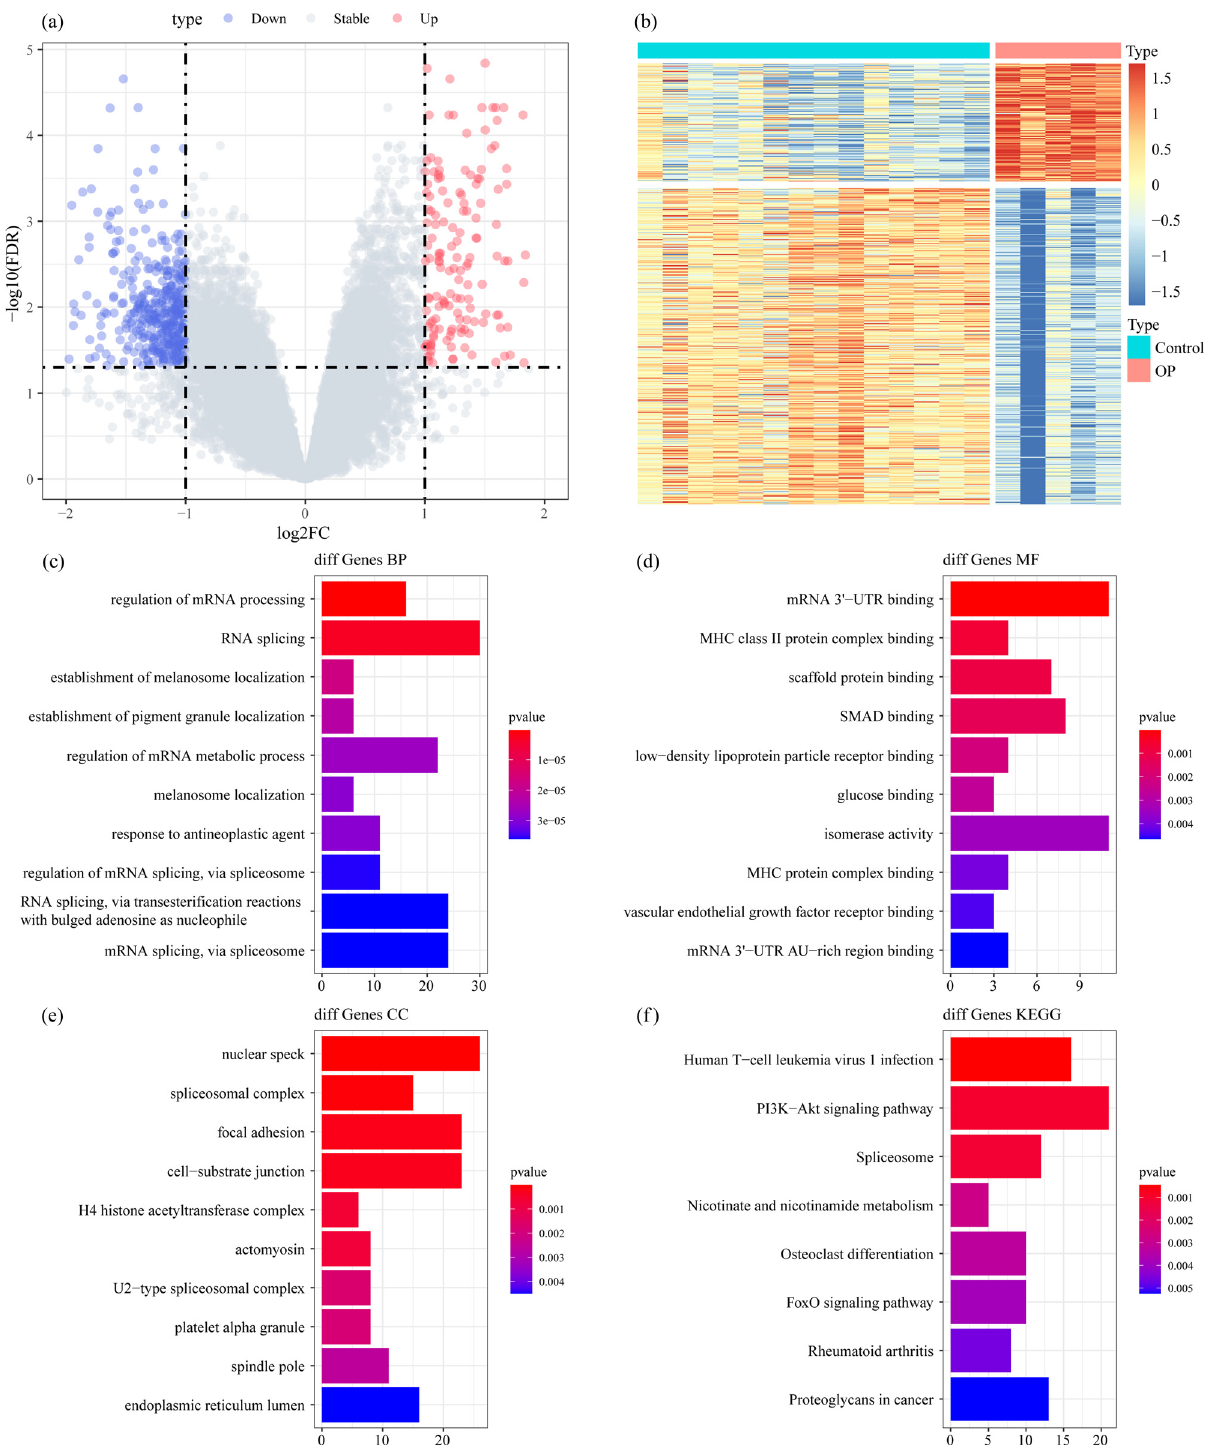
Figure 2: Identi fi cation of DEGs: ( a ) the volcano map of DEGs in GSE35959 dataset, ( b ) the heat map of DEGs in GSE35959 dataset, ( c ) the BP annotation map of DEGs, ( d ) the CC annotation map of DEGs, ( e ) the MF annotation map of DEGs, and ( f ) the KEGG annotation map of a total of 15 modules ( Figure 3c ) . The correlation between the green and pink modules were signi fi cantly positively each module and the sample type ( osteoporosis and con - correlated with osteoporosis, and that the tan module trol ) was further analyzed. The results demonstrated that was obviously negatively correlated with osteoporosis